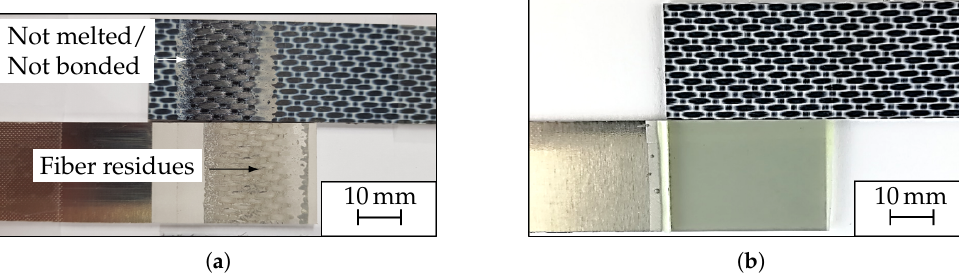
Figure 7. Comparison of the 25mm wide samples after the tensile test: ( a ) joined with parameter set III-PSa; and ( b ) joined with an epoxy-based